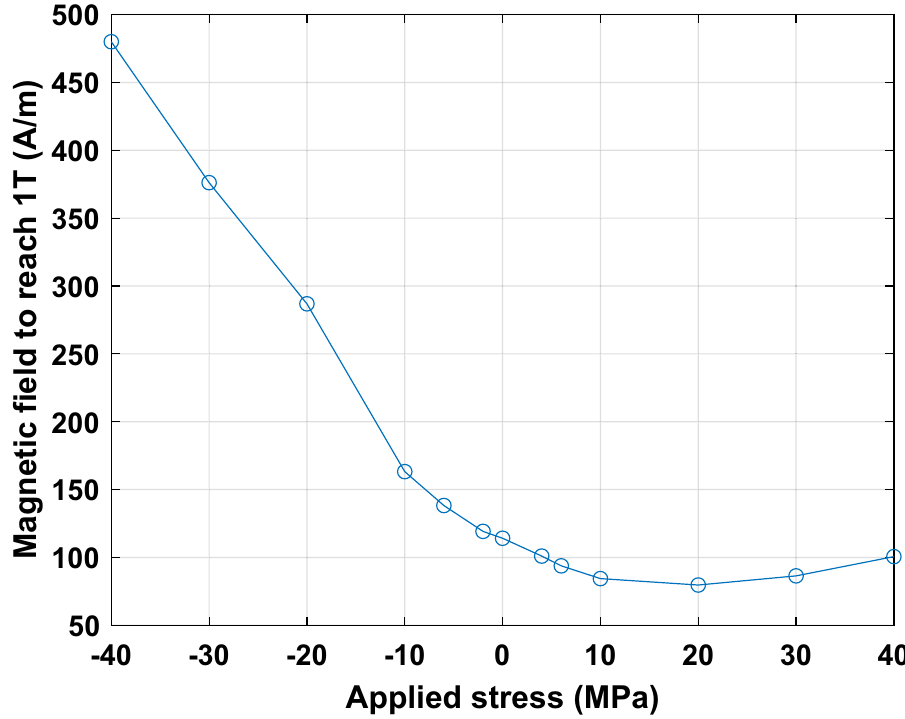
Figure 26. Evolution of the magnetic field necessary to reach 1 T as a function of applied mechanical stress.